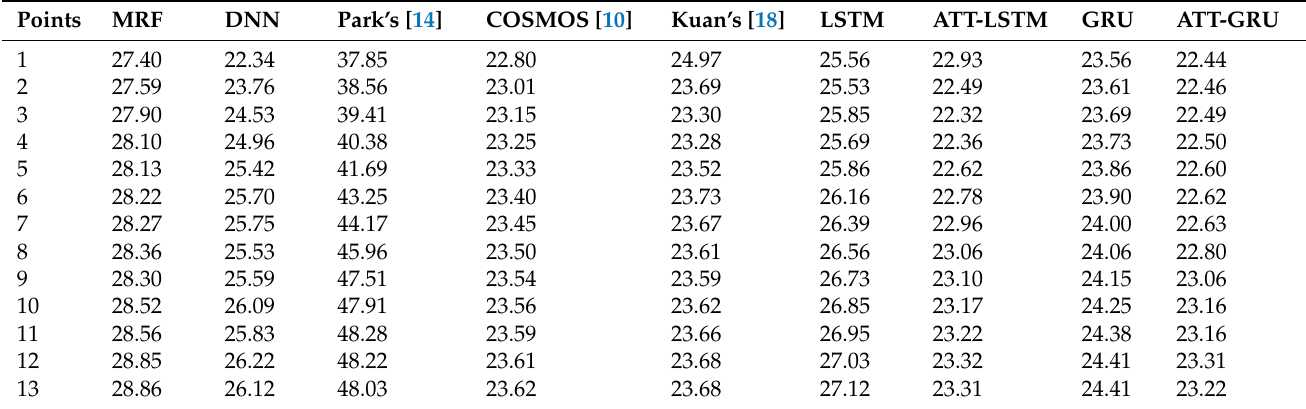
Table A4. Coefficient of variation of the root mean squared error comparison for Building